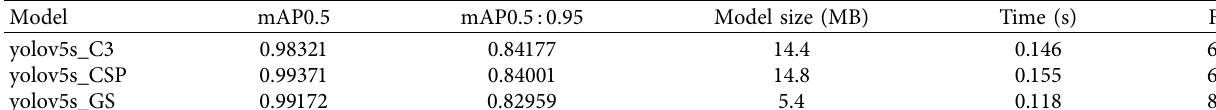
Table 4: Performance indexes of different models.